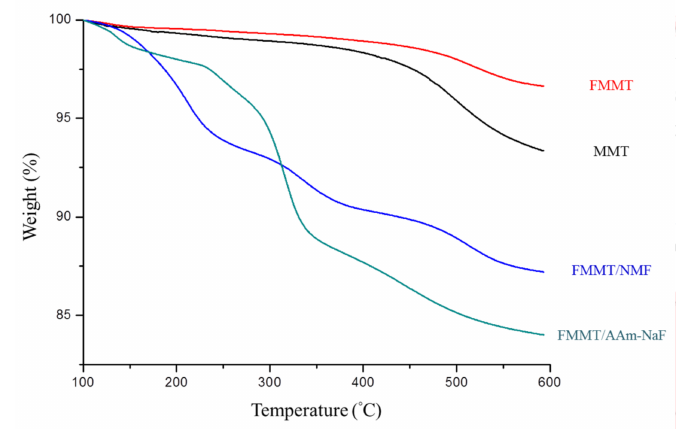
Figure 3. TGA patterns of MMT, FMMT, FMMT-NMF, and FMMT-AAm-NaF between 100 and 600 ◦ C.